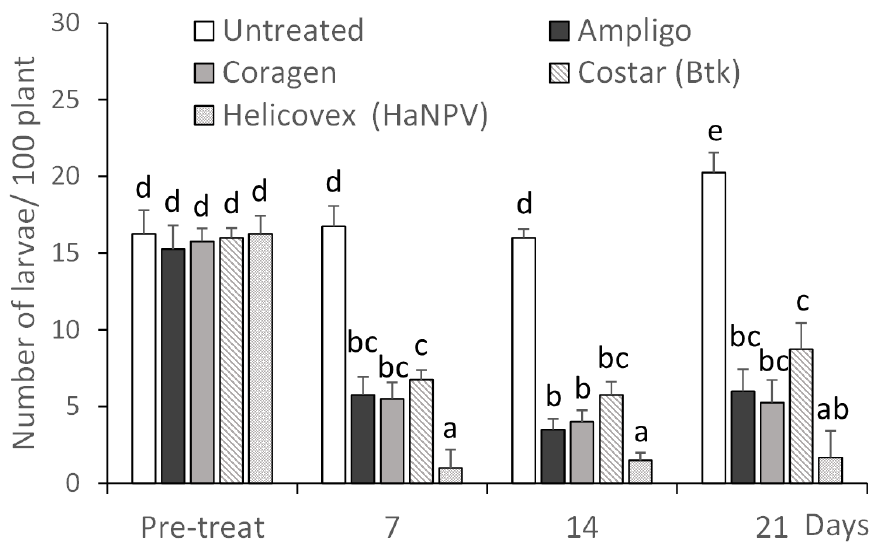
Figure 2. Density (mean ± SD) of H. armigera larvae assessed on plots before (Pre-treat) and after application of different insecticidal products. Different letters above bars indicate significant differences among means (ANOVA Mixed Proc., p < 0.05).